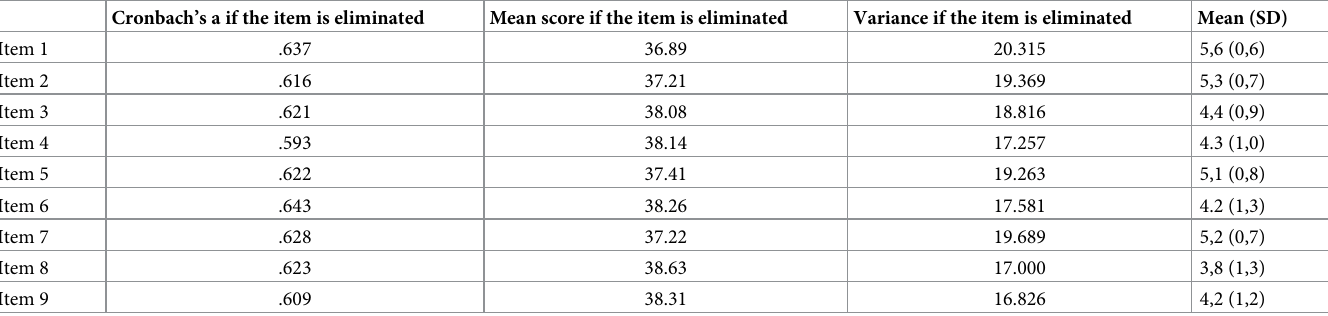
Table 3. Cronbach’s α and moral sensitivity questionnaire index for each item.